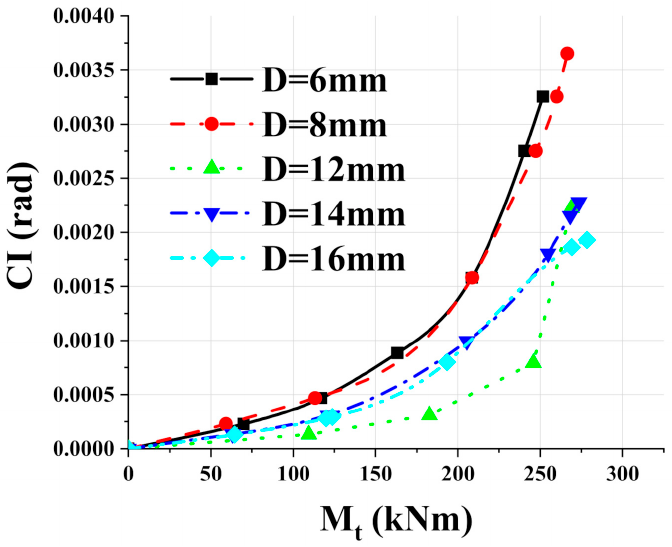
Figure 15. Continuity index-moment curves of connections with different end plate thickness.